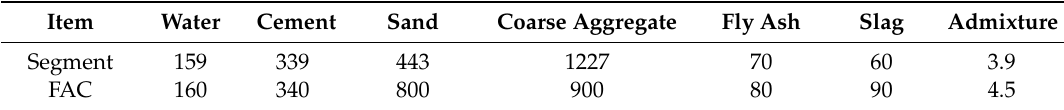
Figure 2. Details of strengthened specimen (unit: mm). ( a ) Elevation view; ( b ) section 3-3; ( c ) details of concrete-filled steel tubes (CFSTs).